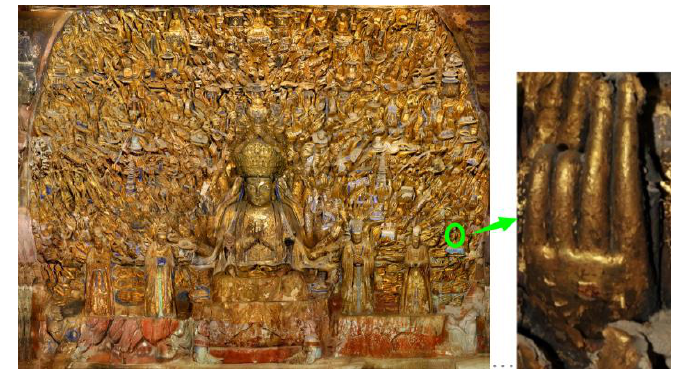
Figure 11. An ortho-photo map of the Dazu Thousand-Hand Bodhisattva Statue and a panoramic of the partial view at Giant Buddha Bay.